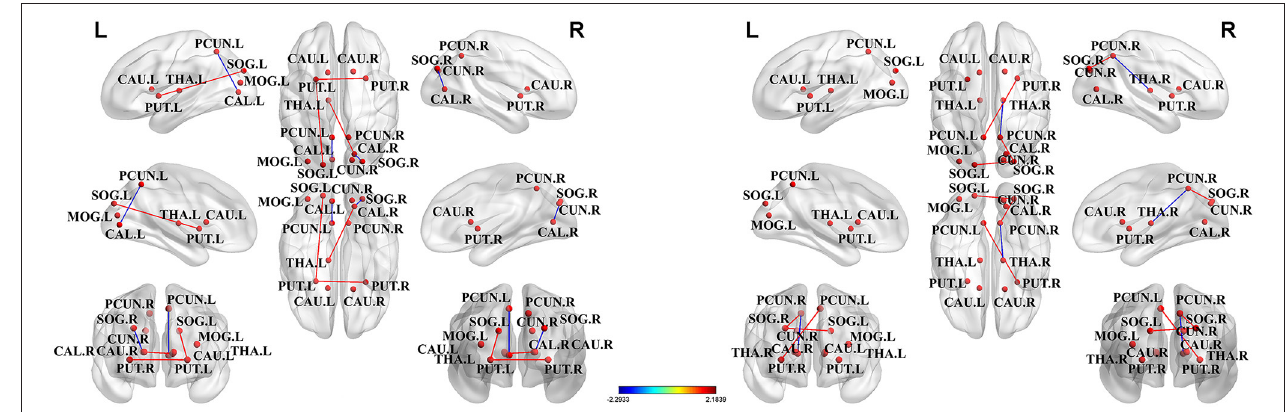
FIGURE 3 | The hub nodes of structural network across the group. Red dots represented the brain hub nodes of the brain, lines between nodes represented the abnormal connections between hub nodes, red lines indicated the enhancement connection, and blue lines indicated the reduced connection. PCUN, precuneus; SOG, superior occipital gyrus; MOG, middle occipital gyrus; CAL, calcarine fissure and surrounding cortex; PUT, putamen; CAU, caudate nucleus; THA, thalamus; CUN, cuneus.